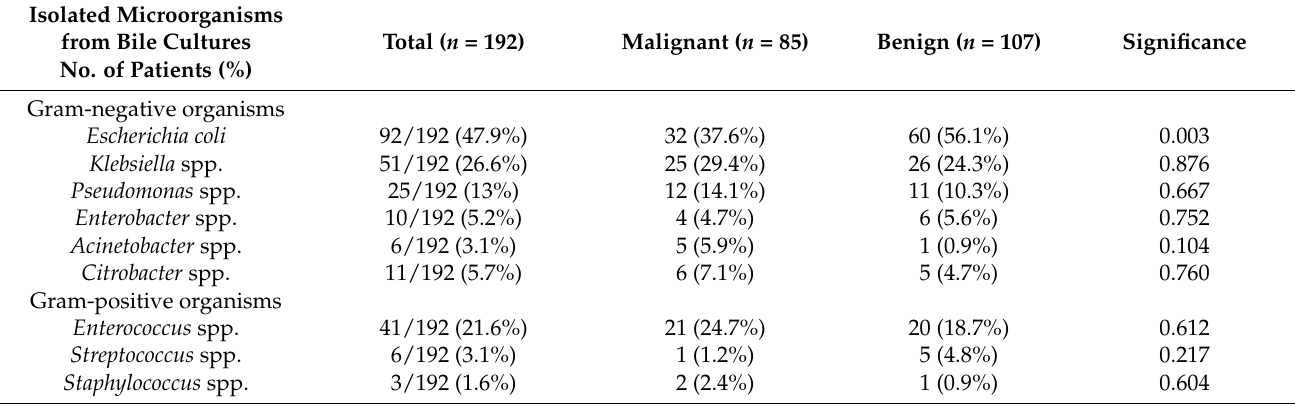
Table 4. Comparison of isolated microorganisms from bile cultures between patients with malignant and benign etiologies of